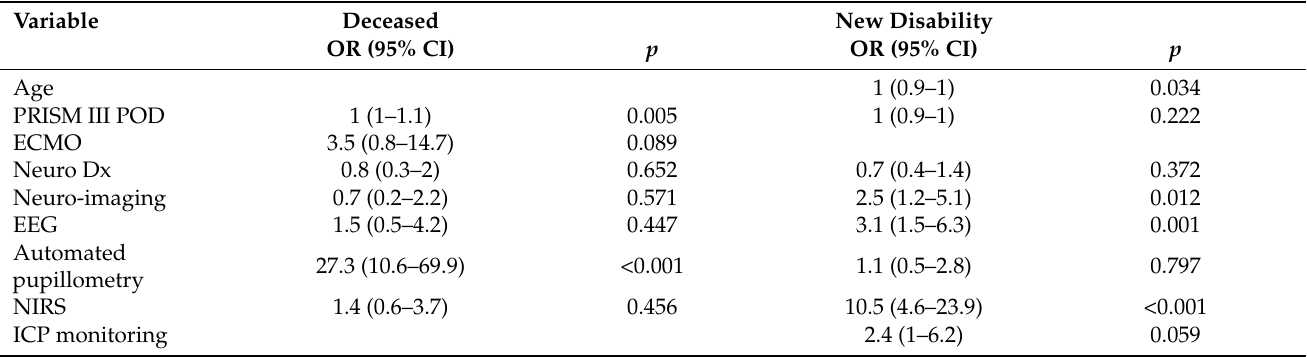
Table 3. Logistic Regression with Neuromonitoring Use, Covariates, and Hospital